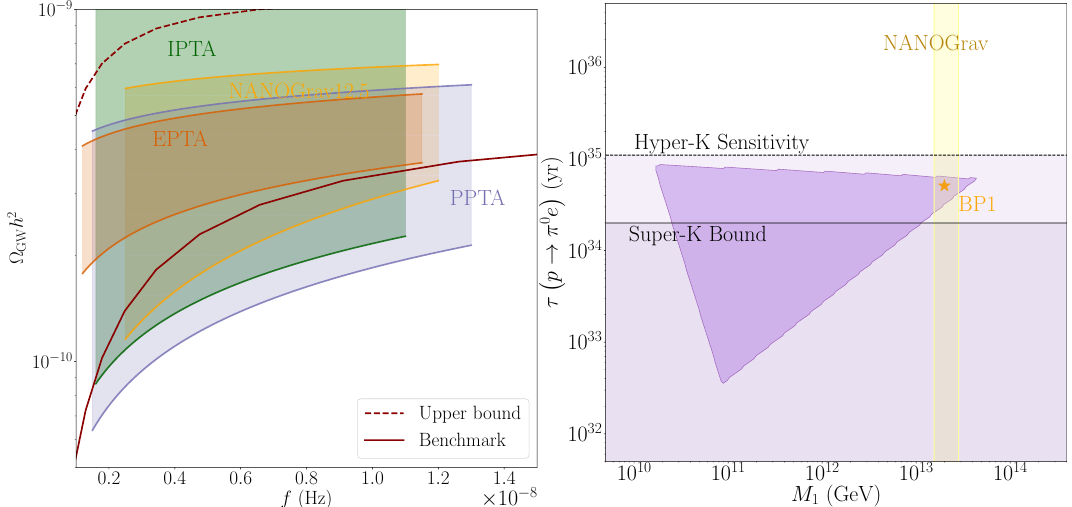
Figure 9 . Left: blown-up image of the nHz region of the gravitational waves spectrum of the benchmark point and the upper bound. This is compared with the region of EPTA, IPTA, PPTA and NANOGrav consistent with the observation of an SGWB. Right: proton decay lifetime compared with the region of M1 consistent with NANOGrav12.5, we can see that there is a region of the parameter space which can be tested by Hyper-K, which is consistent with NANOGrav. The orange star indicates